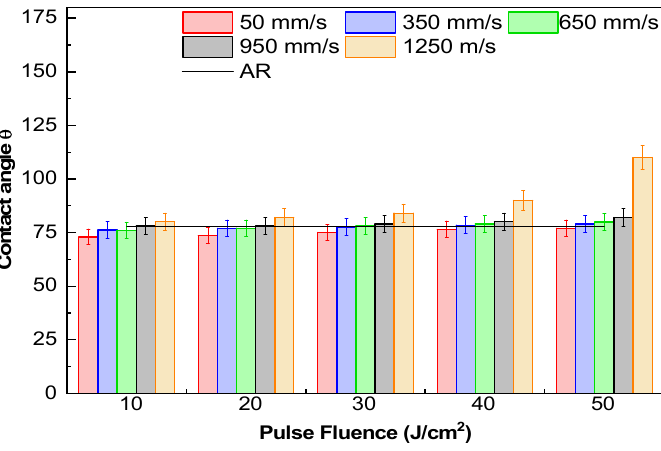
Figure 5. Measured contact angle of PA2200 obtained by stamping of Titanium samples.